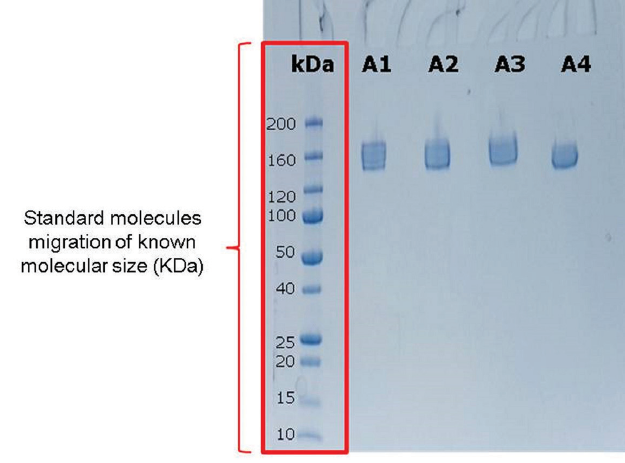
FIGURE 2 - Electrophoresis in 4-20% Tris-Glicin gel: A1 / A3 (Cetuximab samples); A2 / A4